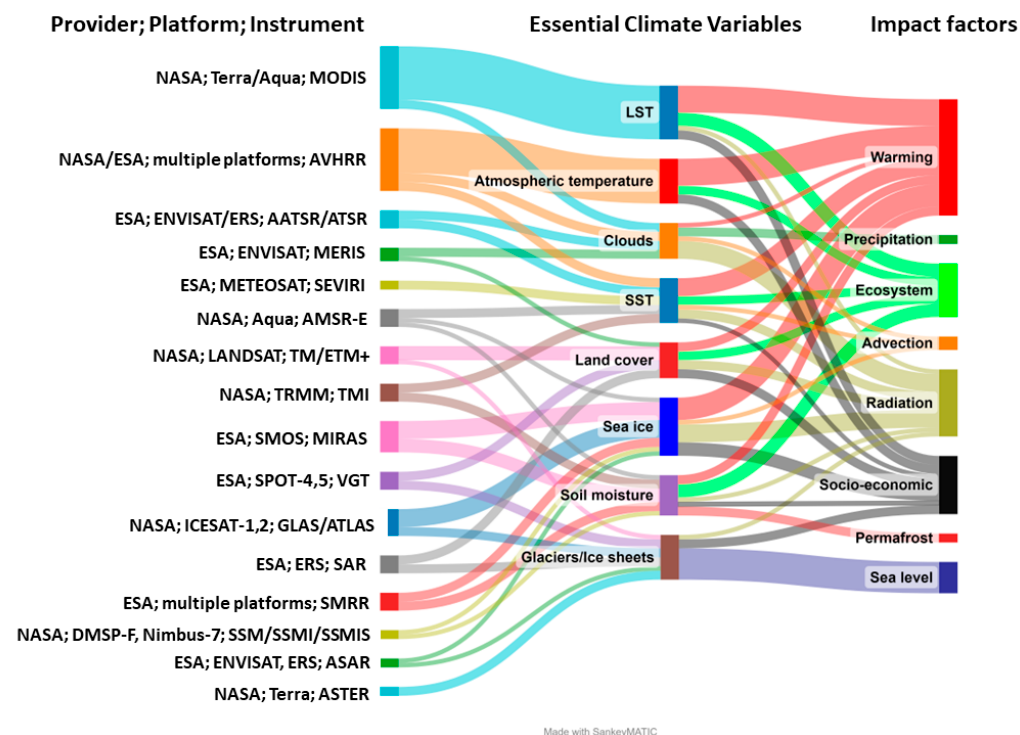
Figure 9. Primary satellite sensors contributing to the amplification ECVs in the ESA CCI